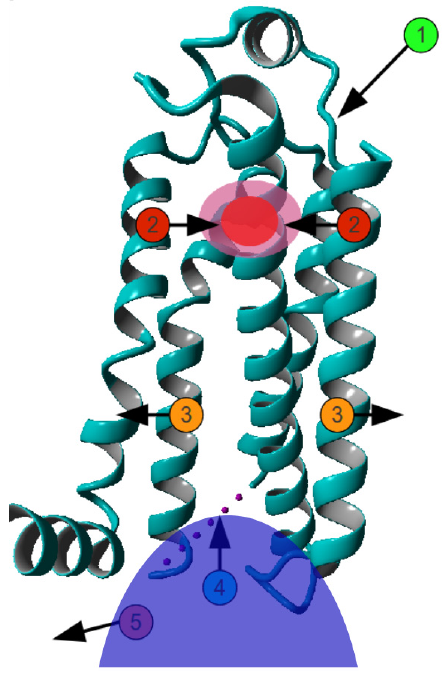
α -Bulges tend to remain stable in molecular dynamics simulations, indicating that these bulges represent (at least) a local energy minimum (DE Gloriam, personal communication). Figure 4. Mechanism of GPCR activation. Agonist binding ( 1 ) induces inward motions ( 2 ) of the extracellular side of helices V–VII. This is accompanied by an outward movement of the cytosolic side of helices V–VII ( 3 ), allowing the G protein (shown as solid blue blob) to bind ( 4 ) and become activated ( 5 ). Obviously, there is no fixed order in the motions. The determination of what moves where depends largely on the superposition method used.